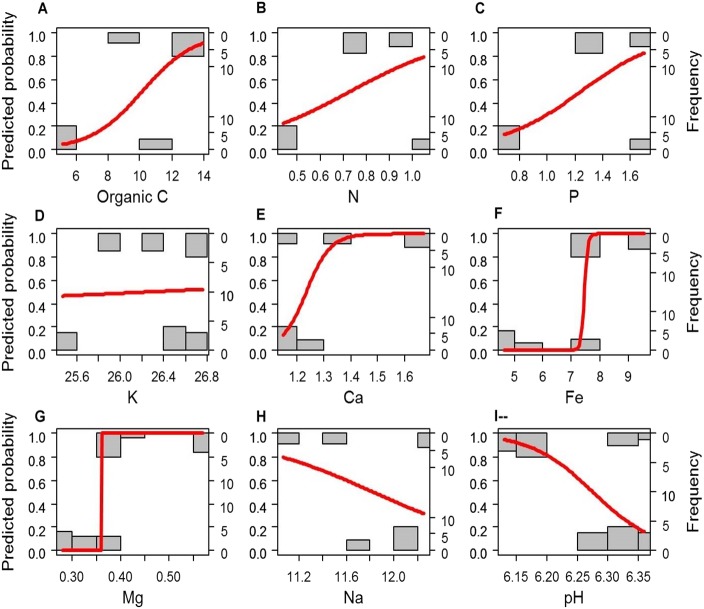
A simple logistic regression model revealing significant prediction of the absence (0) and presence (1) of forestation based on the contents of the soil elements (A–H) and pH (I).(A) Organic C; (B) N; (C) P; (D) K; (E) Ca; (F) Fe; (G) Mg; (H) Na); (I) pH.